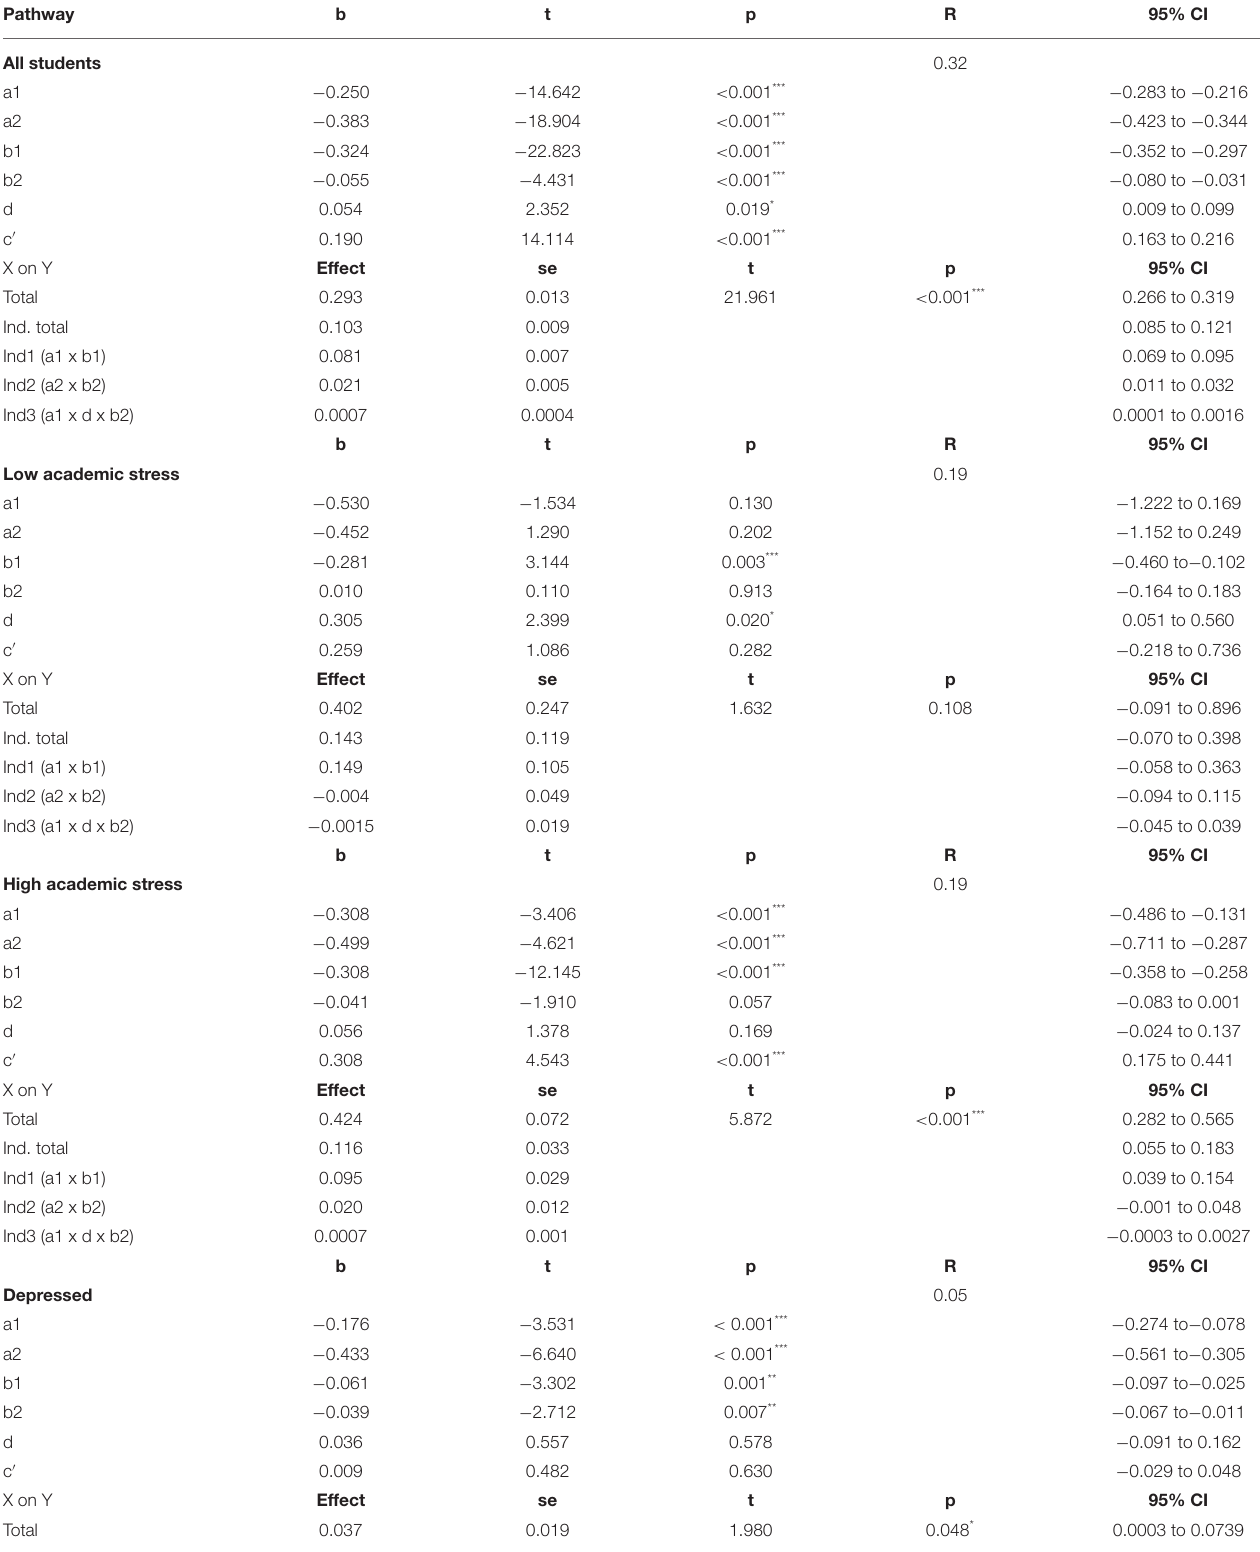
TABLE 4 | Regression coefficients and significance tests for the explanatory model pathways between the five student groups. Pathway